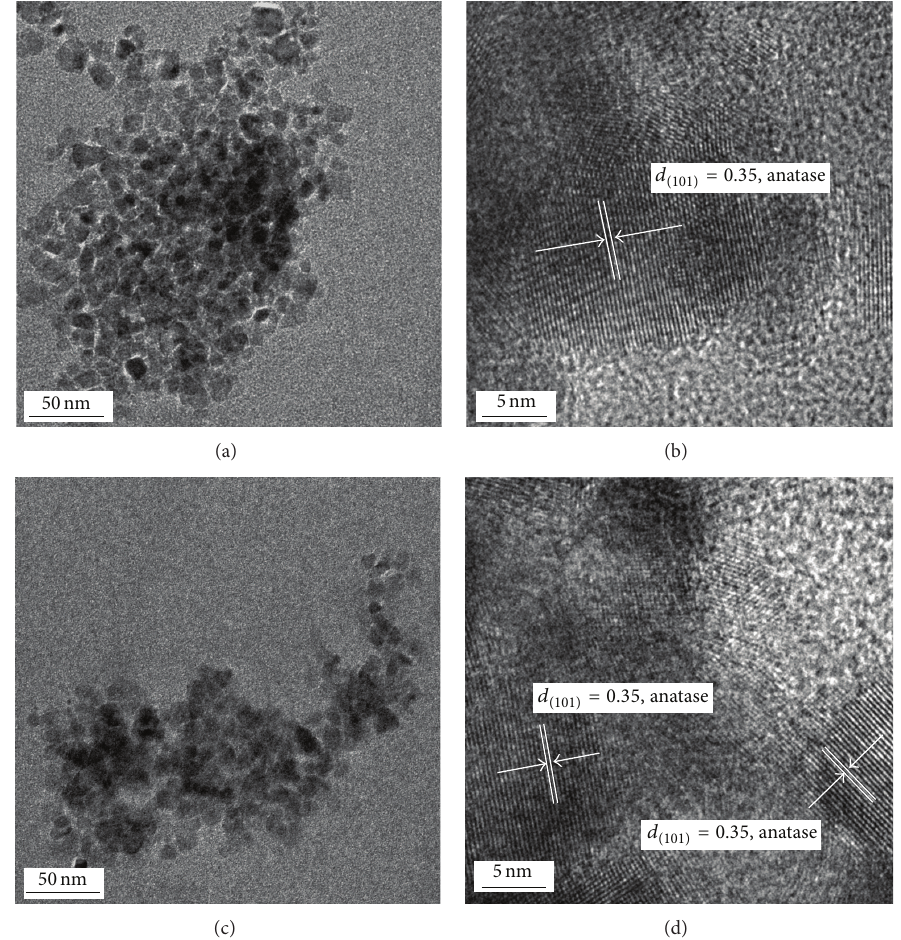
Figure 4: (a) and (c) TEM images of mesoporous nanocrystalline anatase samples AB4 and SR4. (b) A magnified image of (a) and (d) a magnified image of (c) with the 𝑑 -spacing (1 0 1) of anatase form of titania.